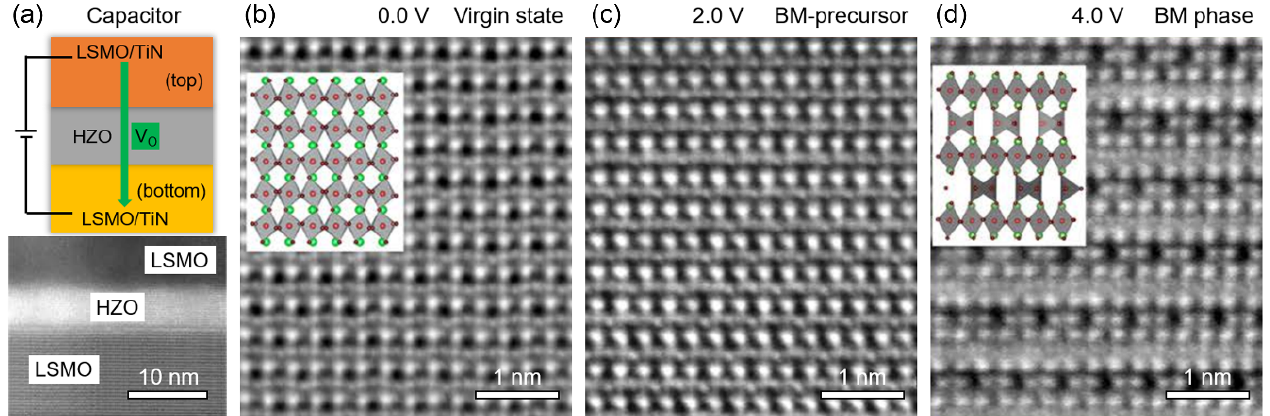
Figure 9. Deoxygenation of the bottom (La 1-x Sr x )MnO 3 (LSMO, x ≈ 1/3) electrode with increasing positive bias in an LSMO/HZO/LSMO capacitor. ( a ) Polarity-dependent oxygen voltammetry process (V O : oxygen vacancy) and morphology of the dielectric capacitor. ( b–d ) The iDPC-STEM images of a representative region of the bottom LSMO layer, showing ( b ) the virgin 0.0 V state, ( c ) the BM precursor phase (with mixed MnO 5 and MnO 6 polyhedra) at 2.0 V and ( d ) the BM phase at 4.0 V viewed along the [110] c zone axis. The atom types in the insets are La/Sr—green, Mn—red and O—brown [158].